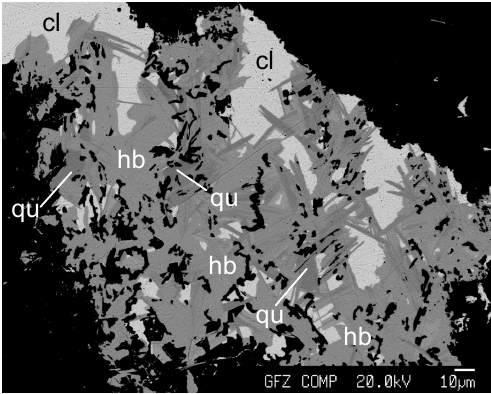
Figure 1. Back-scattered electron (BSE) image showing quijarroite (qu, dark grey) subparallel to and intergrown with hansblockite (hb, light grey) and associated with clausthalite (cl, bright).